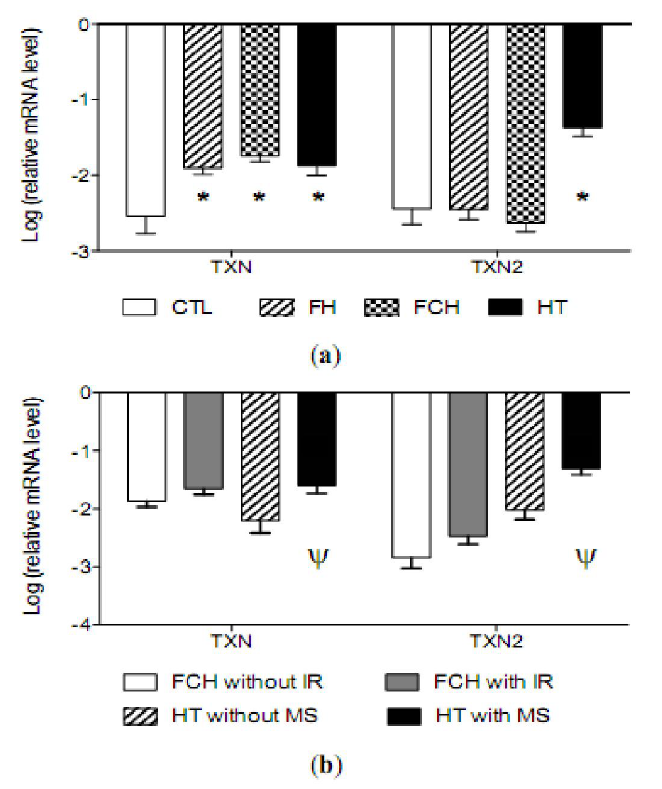
Figure 3. Thioredoxin (TXN) and mitochondrial thioredoxin (TXN2) log ratio relative mRNA values in mononuclear cells of ( a ) controls ( n = 20, CTL), familial hypercholesterolemia ( n = 17, FH), familial combined hyperlipidemia ( n = 30, FCH) and hypertensives ( n = 43, HT); and ( b ) FCH without insulin resistance ( n = 13, FCH without IR), FCH with insulin resistance ( n = 17, FCH with IR), HT without metabolic syndrome ( n = 21, HT without MS) and HT with metabolic syndrome ( n = 22, HT with MS) of